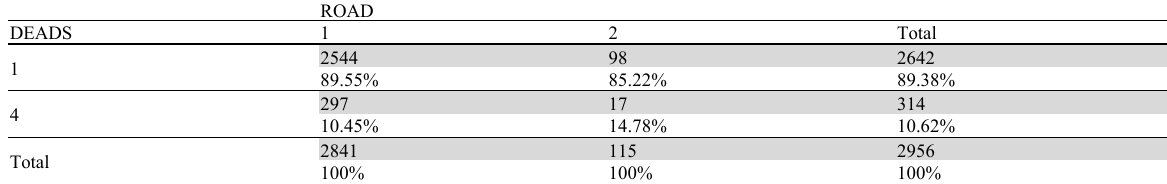
Number of cases between road administration and deaths quantiles